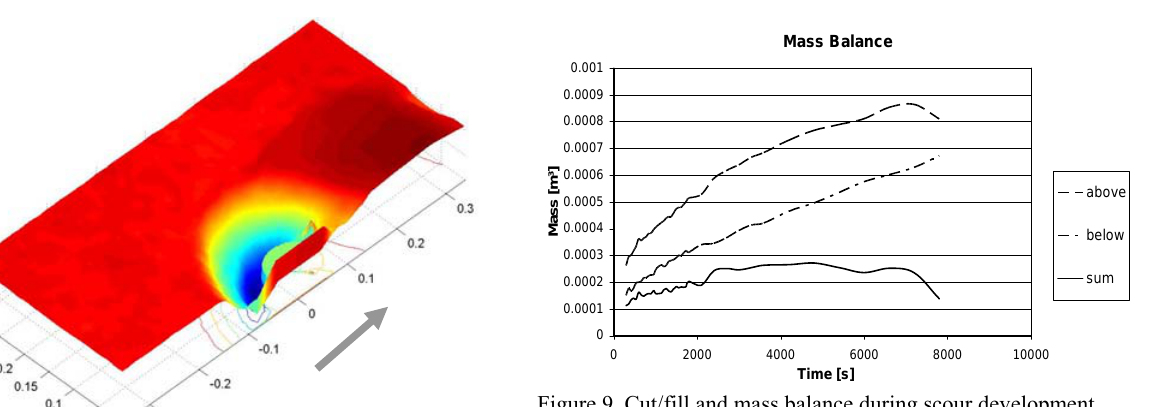
Figure 9. Cut/fill and mass balance during scour development